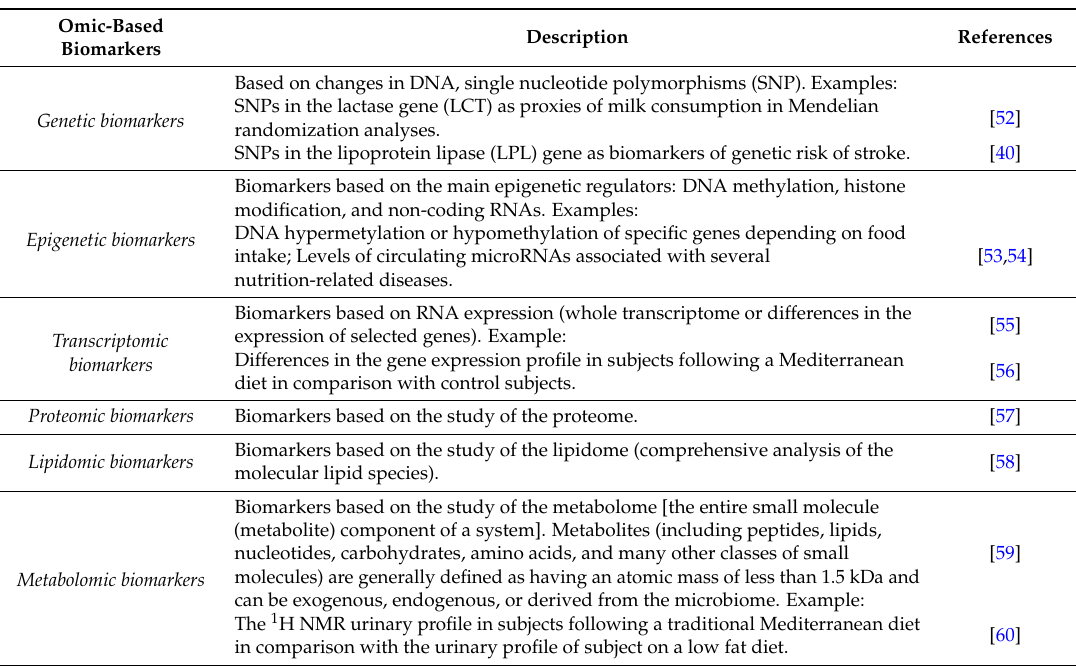
Table 2. Classification of new omic-based